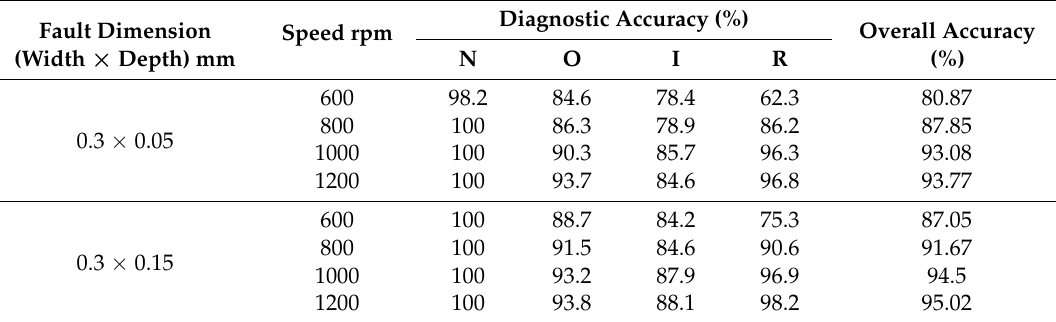
Table 7. Diagnostic results in different operating